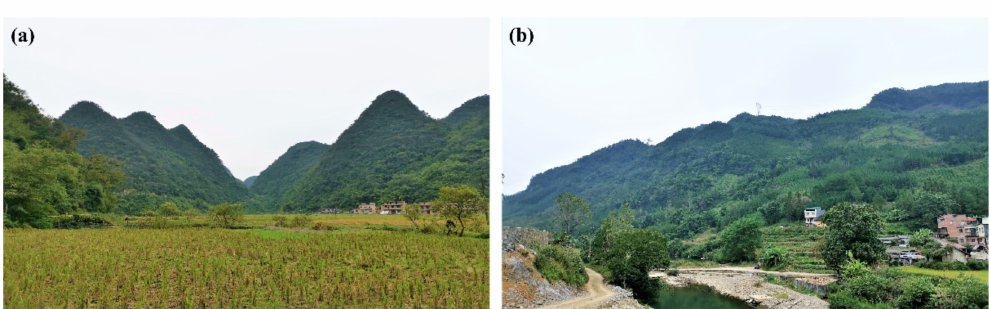
Figure 9. Field photographs showing the typical geomorphic landscapes in the Libo. ( a ) Cone karst landscape observed at Dongduo village, Maolan area; ( b ) Carbonate hilly landscape observed near Jiarong